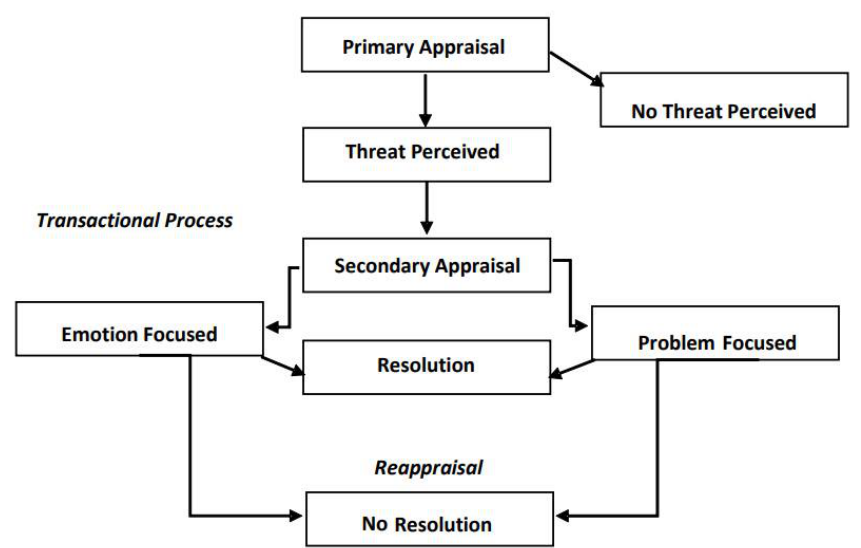
Figure 1. Transactional Model of Stress and Coping.